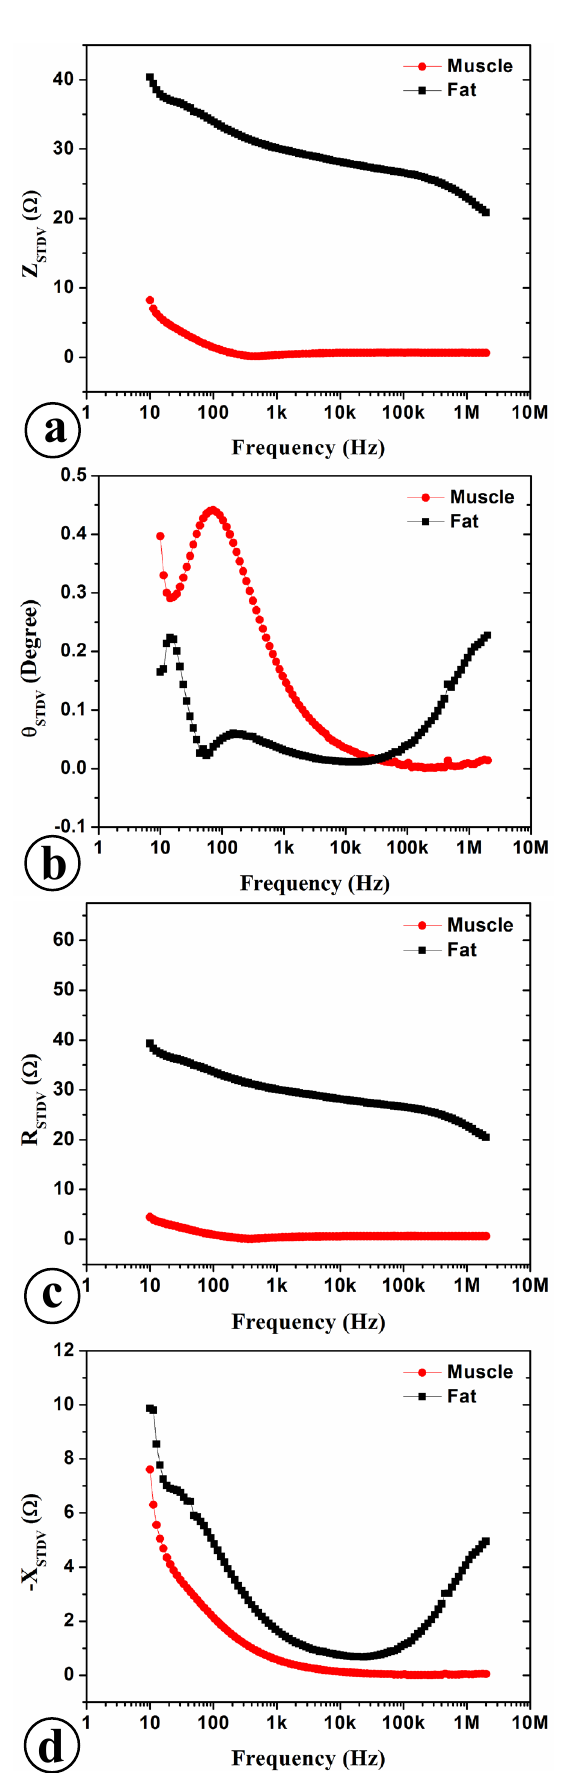
Figure-12: STDV of the impedance parameters of chicken muscle tissue paste and fat tissue: (a) Z, (b) θ, (c) R, (d)